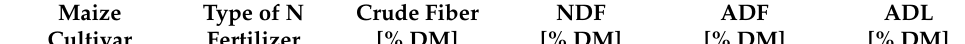
Table 9. Average values of structural carbohydrates for the combination of cultivar (A) and fertilizer (B). Maize Type of N Cultivar